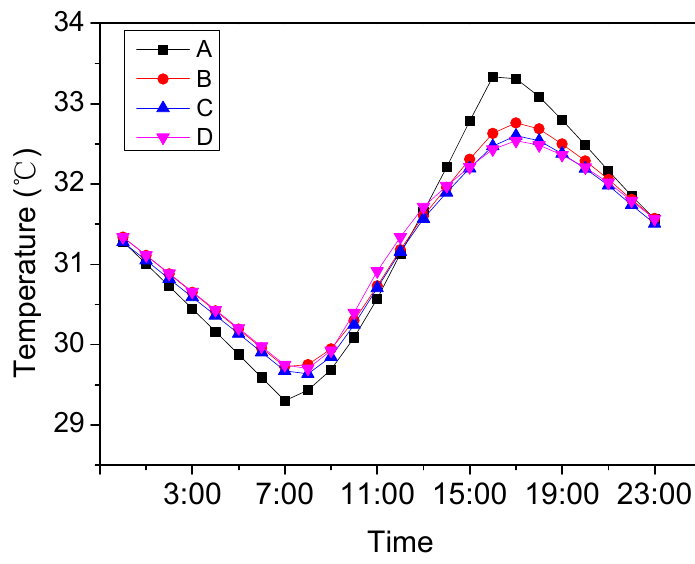
Figure 5. The variation of air temperature with time.